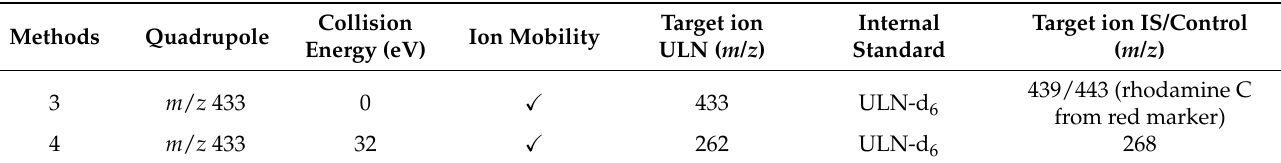
Table 2. Summary of the acquisition methods tested for the quantification of ulixertinib in tissue sections using DESI-IM-MS and DESI-IM-MS/MS.